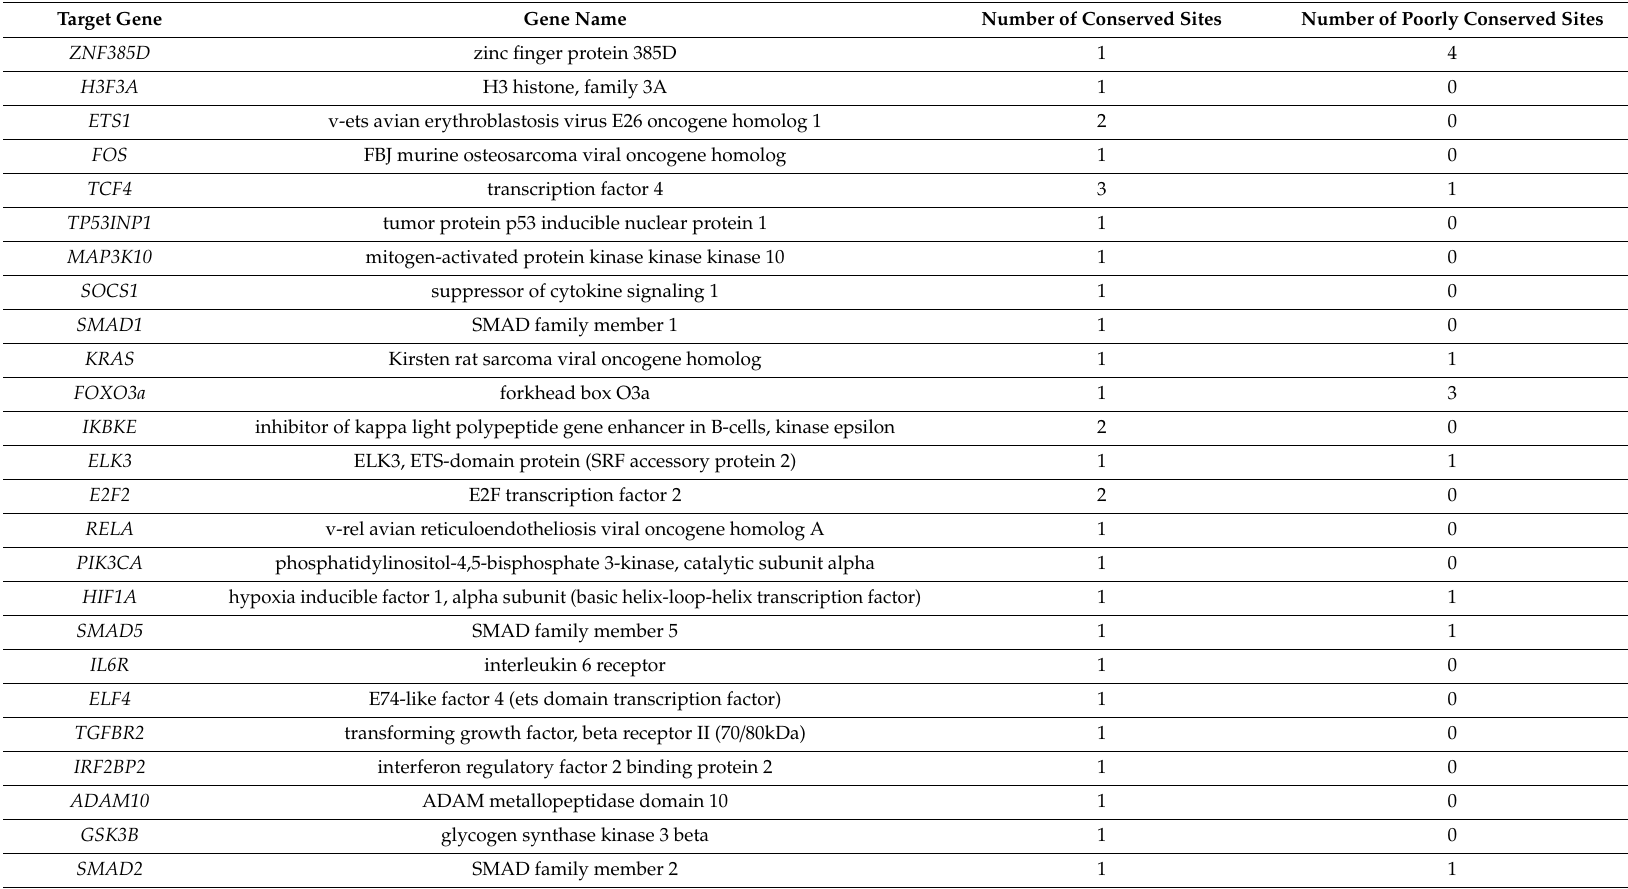
Table 2. Selected predicted targets of miR-155-5p , as determined by